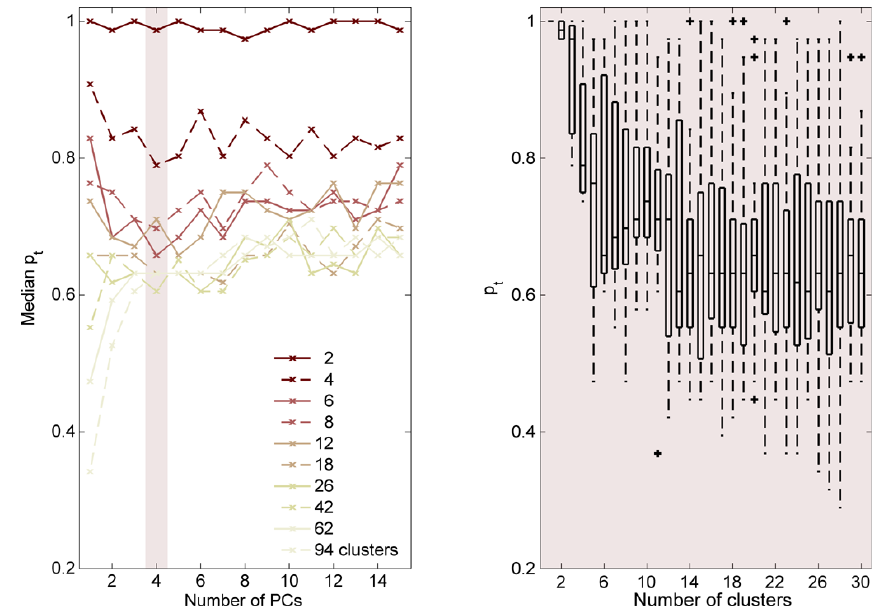
Fig. 5. Median probability of cluster membership p t of different PC-cluster combinations (left). PC-cluster combinations with a small median p t are strongly influenced by model parameterization. Distribution of p t for different numbers of clusters when clustering the leading four PCs